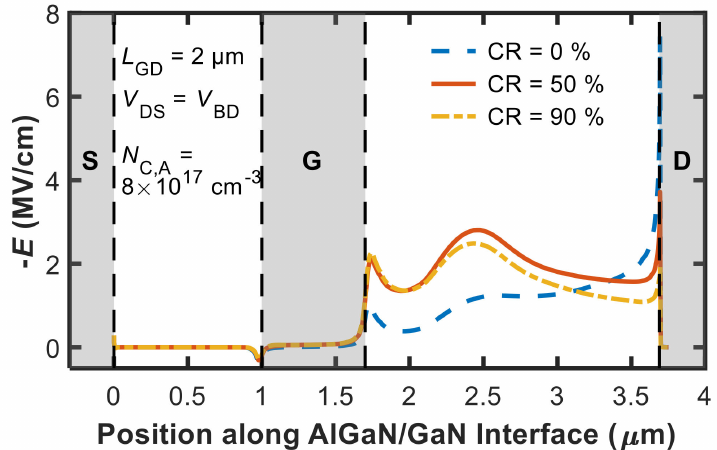
Figure 5. Lateral component of the electric field ( E ) along the AlGaN/GaN interface at breakdown